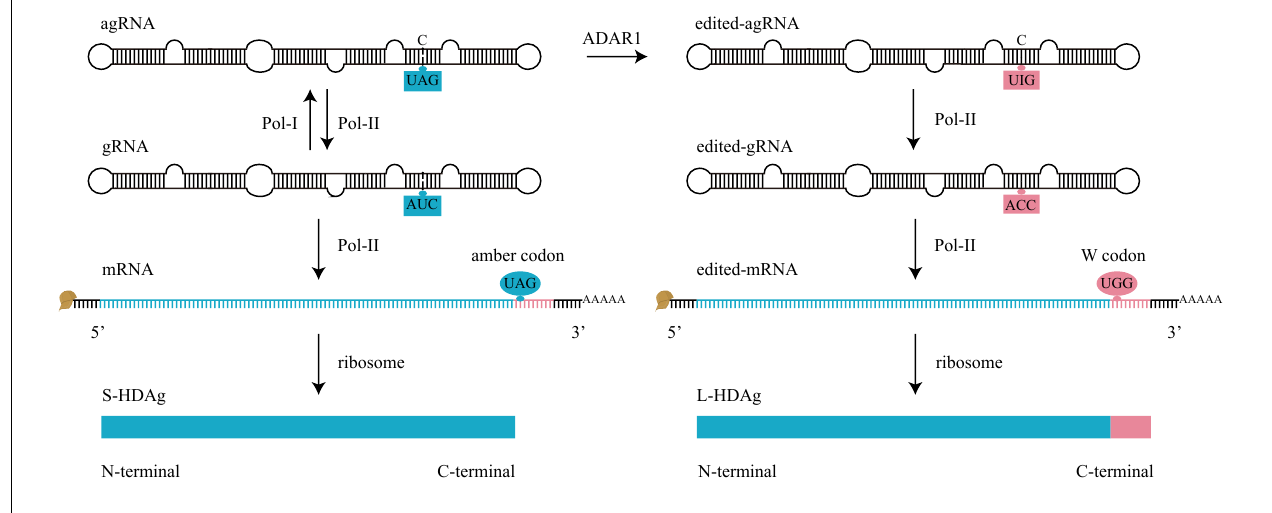
FIGURE 4 | HDV RNA editing. Before editing (left), there is an amber codon (UAG, blue oval) at amber/W site of mRNA, translation will stop here to produce S-HDAg. During editing, adenosine deaminases acting on RNA 1 (ADAR1) converts UAG of agRNA to UIG (right). When Pol-II use these edited-agRNA as a template to replicate edited-gRNA, and use edited-gRNA as a template to transcribe edited-mRNA, there is a W codon (UGG, pink oval) at amber/W site of edited-mRNA, the translation won’t stop until next termination codon is met, producing an L-HDAg. gRNA, genomic RNA. agRNA, antigenomic